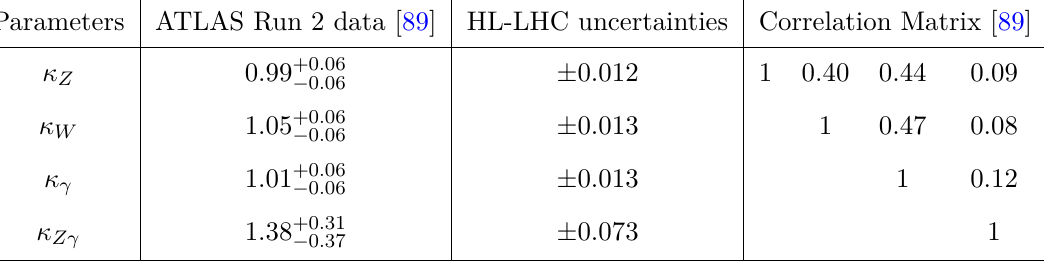
Table 2 . Constraints used for figure 4, based on [89]. Columns 2 and 4 show the ATLAS Run-2 results along with the correlation matrix. In column 3, the HL-LHC projected uncertainties are listed.